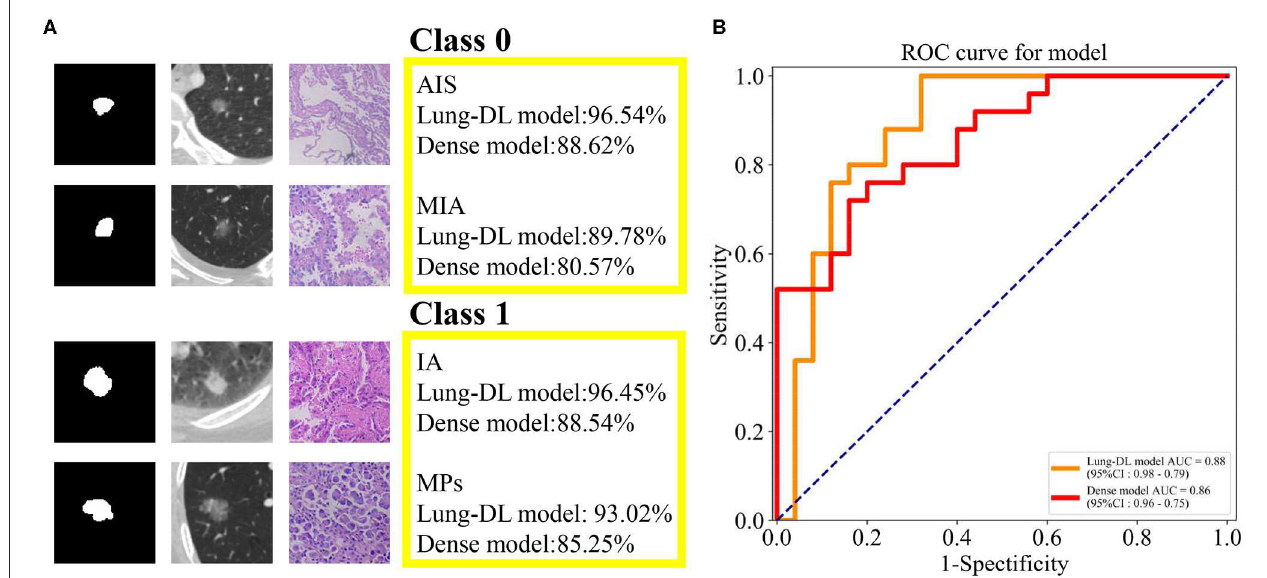
FIGURE 4 | (A) The prediction generated by our two models and the pathologic pattern of the nodule examples. (B) ROC curve generated from the Lung-DL model and the Dense model in the task to distinguish pathologic invasiveness degree. The Lung-DL model yielded an AUC value of 0.88, and the AUC value of the Dense model was 0.86.